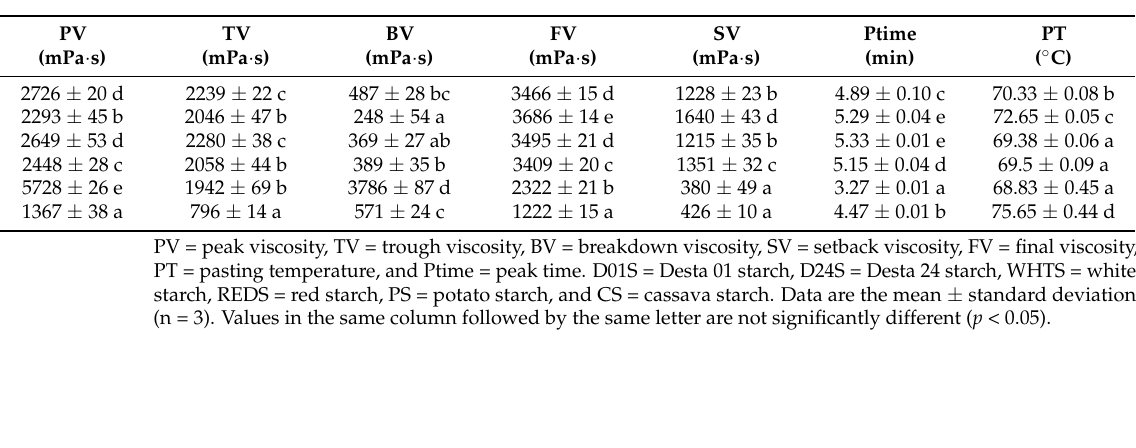
Table 3. Pasting properties of anchote cultivars, potato, and cassava